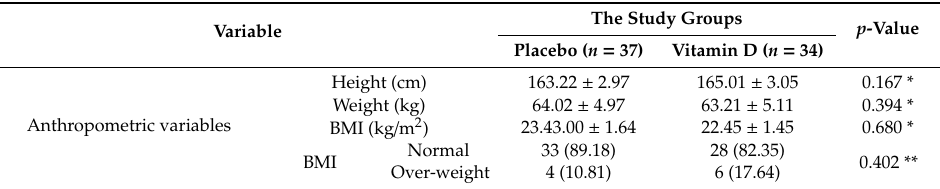
Table 1. The general characteristics of the study